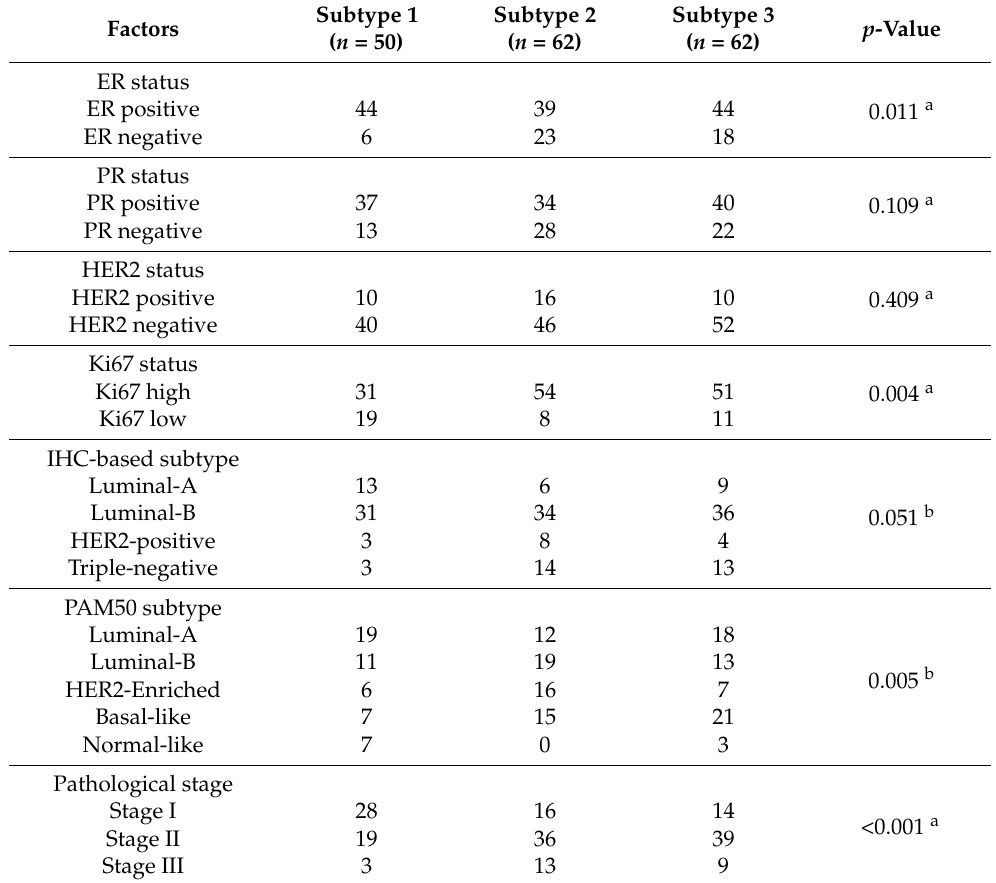
Table 2. Differences of established subtypes and clinical stages for DCE-MRI subtypes in the imaging- subtype discovery cohort. The relationships between three imaging subtypes and established sub- types of BC, including clinical receptor-based, IHC-based and PAM50-based subtypes, as well as the clinical stages, were